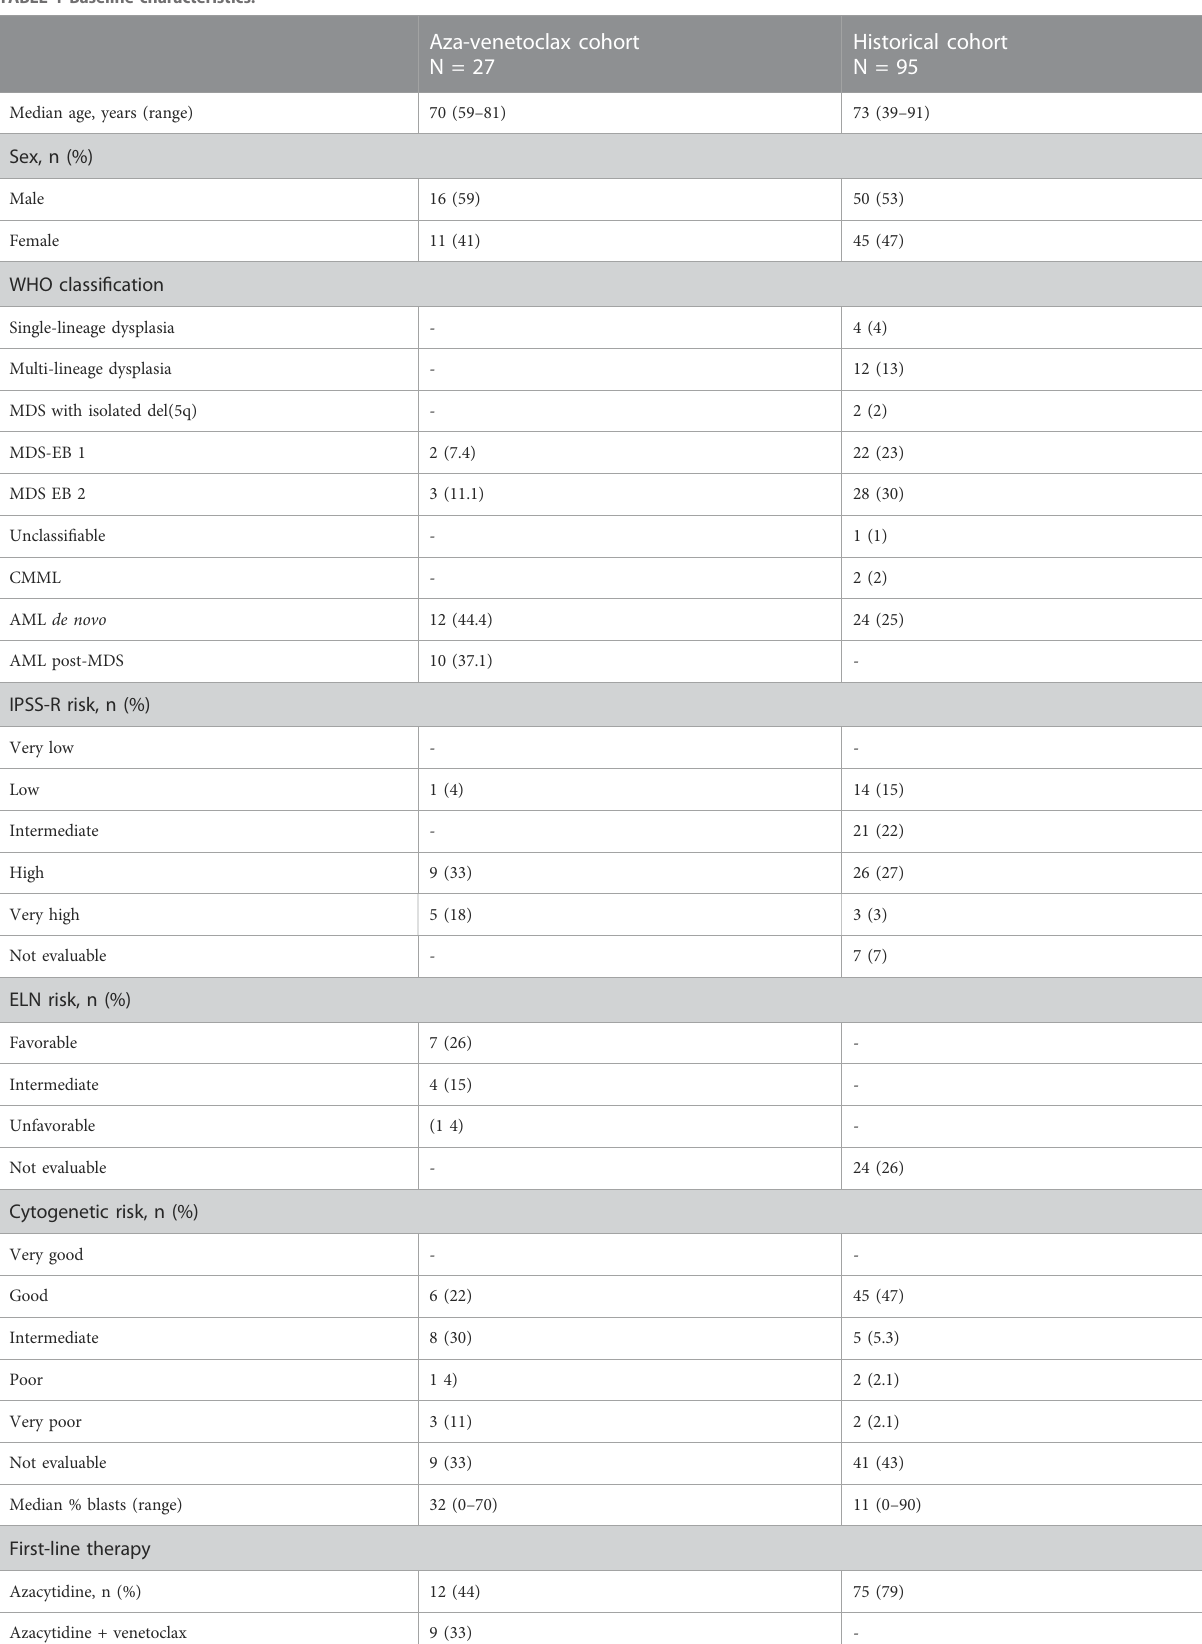
TABLE 1 Baseline